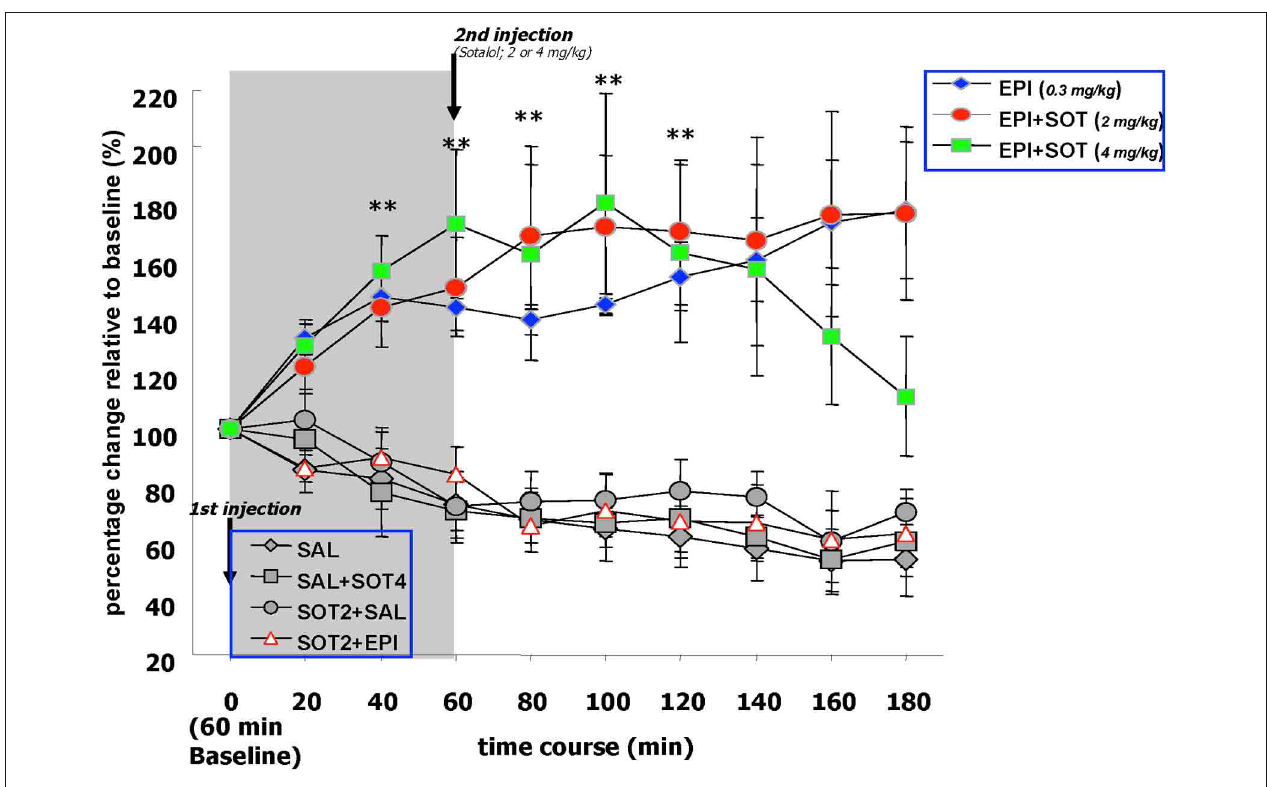
FIGURE 4 | The effects of systemically administered saline, epinephrine (0.3mg/kg), sotalol (2.0 or 4.0mg/kg), or the combination of epinephrine and sotalol on norepinephrine release in the amygdala. Basal levels of norepinephrine were similar across treatment groups during the 60min drug-free baseline period. Norepinephrine concentrations sampled from the amygdala of the EPI and EPI + SOT2 groups showed consistent and